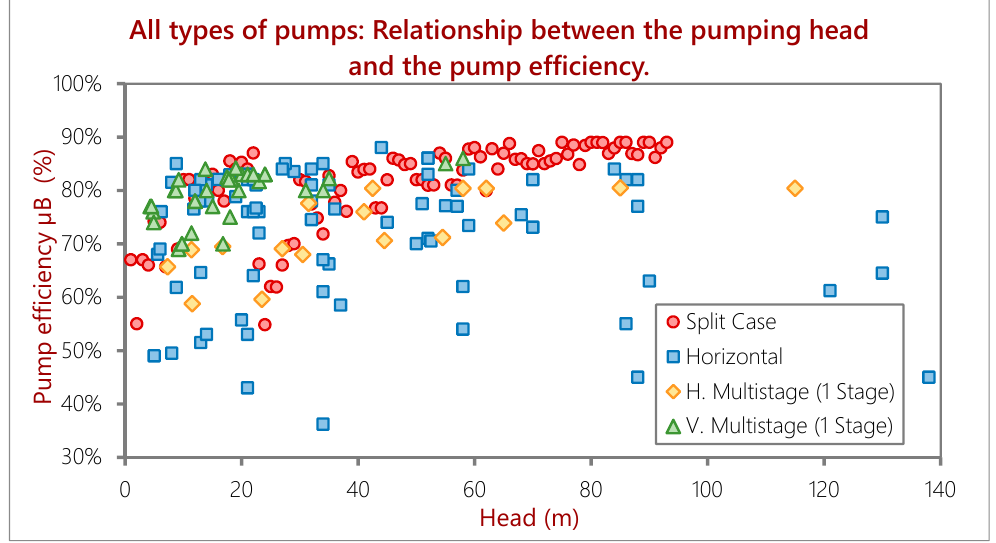
Figure 2. Optimum pump efficiency and the correspondent pumping height at that operating point.